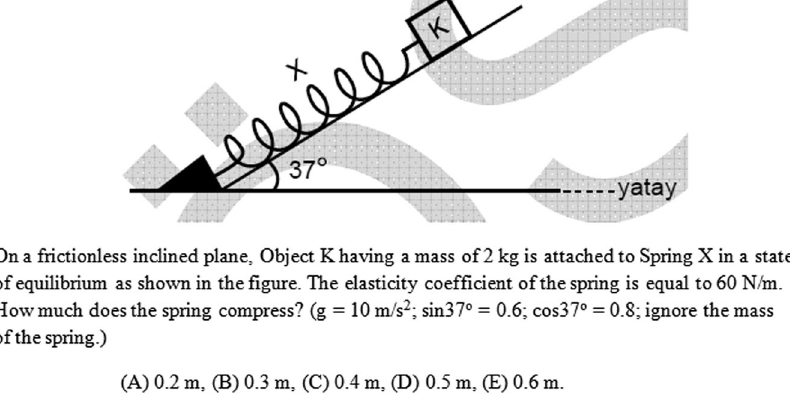
FIG. 1. Item from the second stage of the 2010 CEE physics